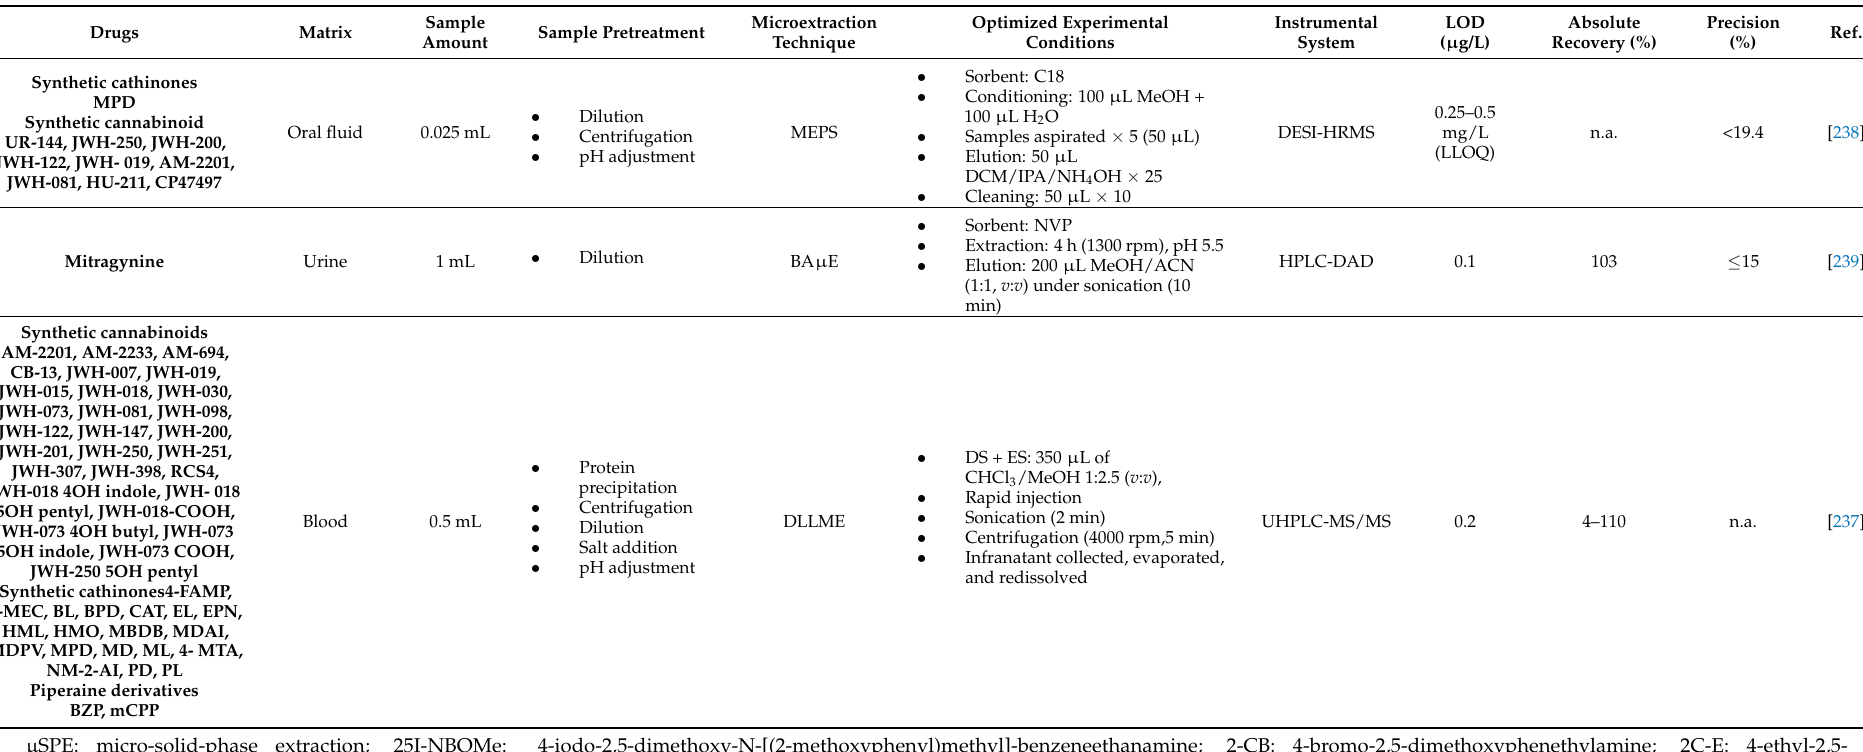
Table 7. Microextraction-based approaches for the analysis of new psychoactive substances (NPS) and related substances in the forensic